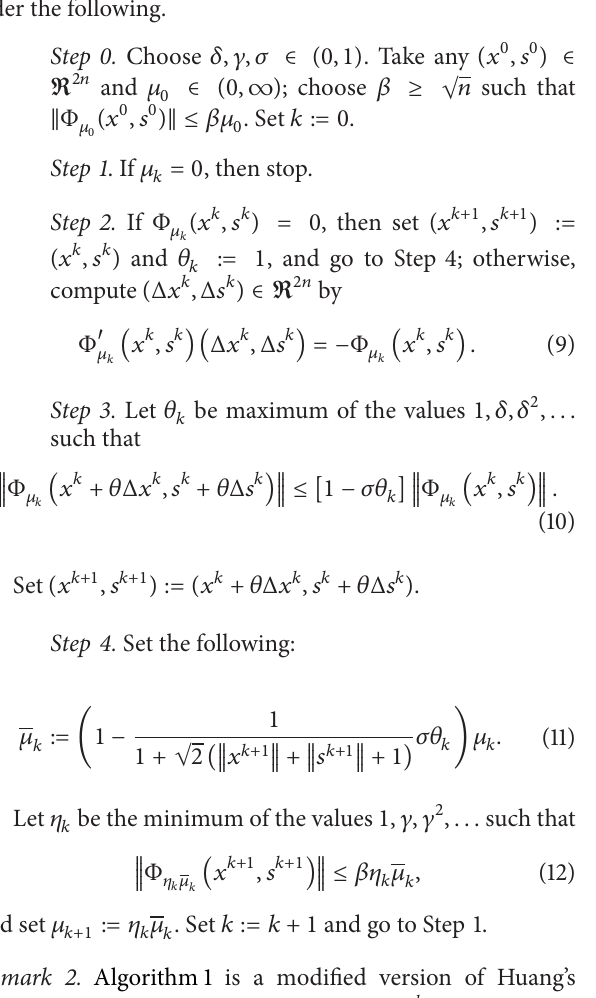
Algorithm 1 (a noninterior continuation algorithm).